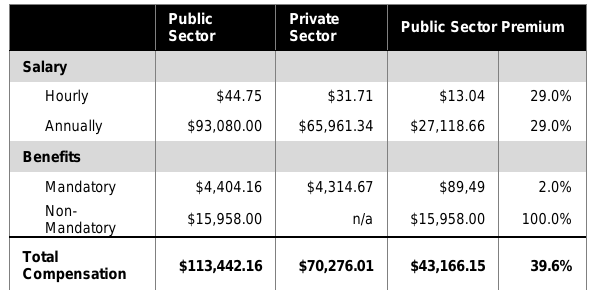
Table 2 : Comparison of Total Compensation for Technicians in the Public and Private